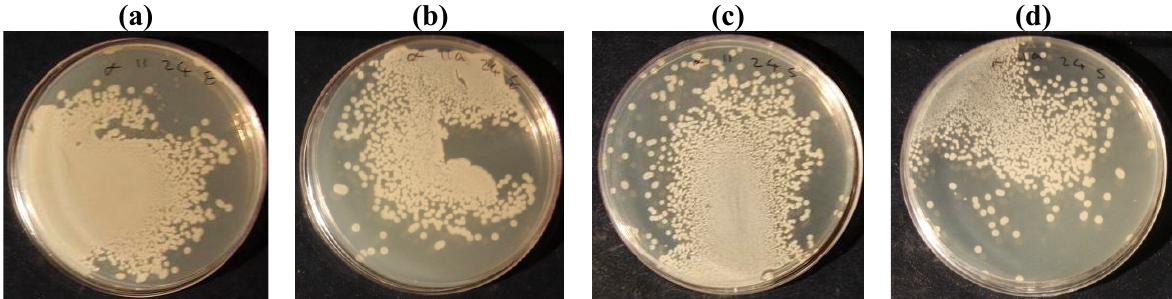
Figure 2. The bacteria colonies of a silver nanoparticles coating on untreated cotton ( a ) Escherichia Coli before laundering; ( b ) Escherichia Coli after laundering; ( c ) Staphylococcus aureus before laundering; ( d ) Staphylococcus aureus after laundering.